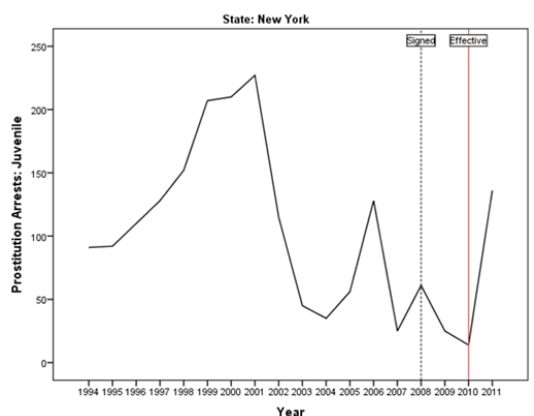
Figure 1. Juvenile prostitution arrests: New